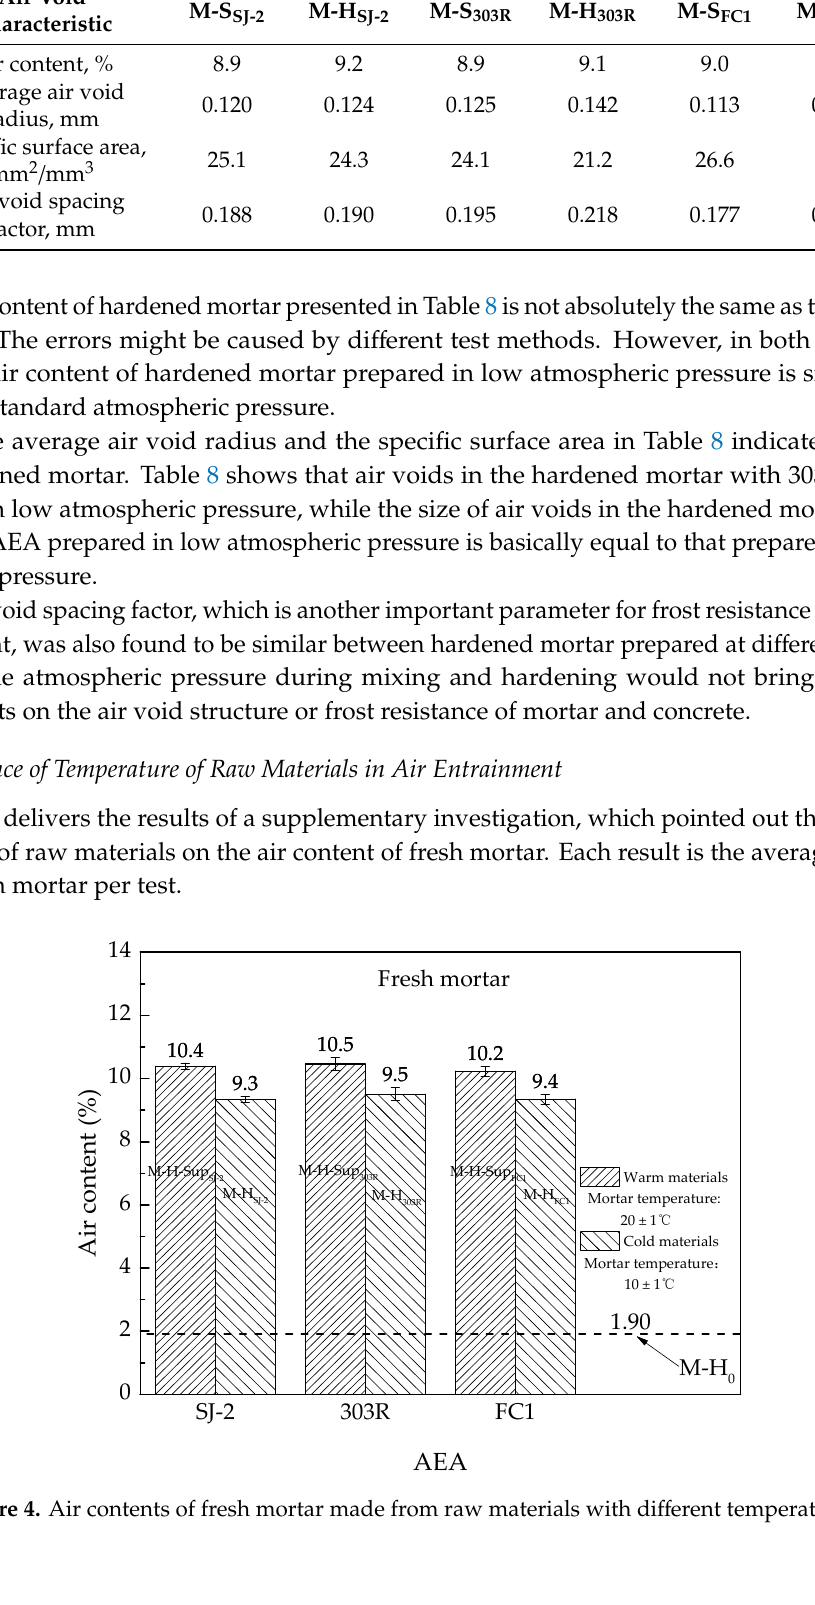
Figure 4. Air contents of fresh mortar made from raw materials with different temperatures.